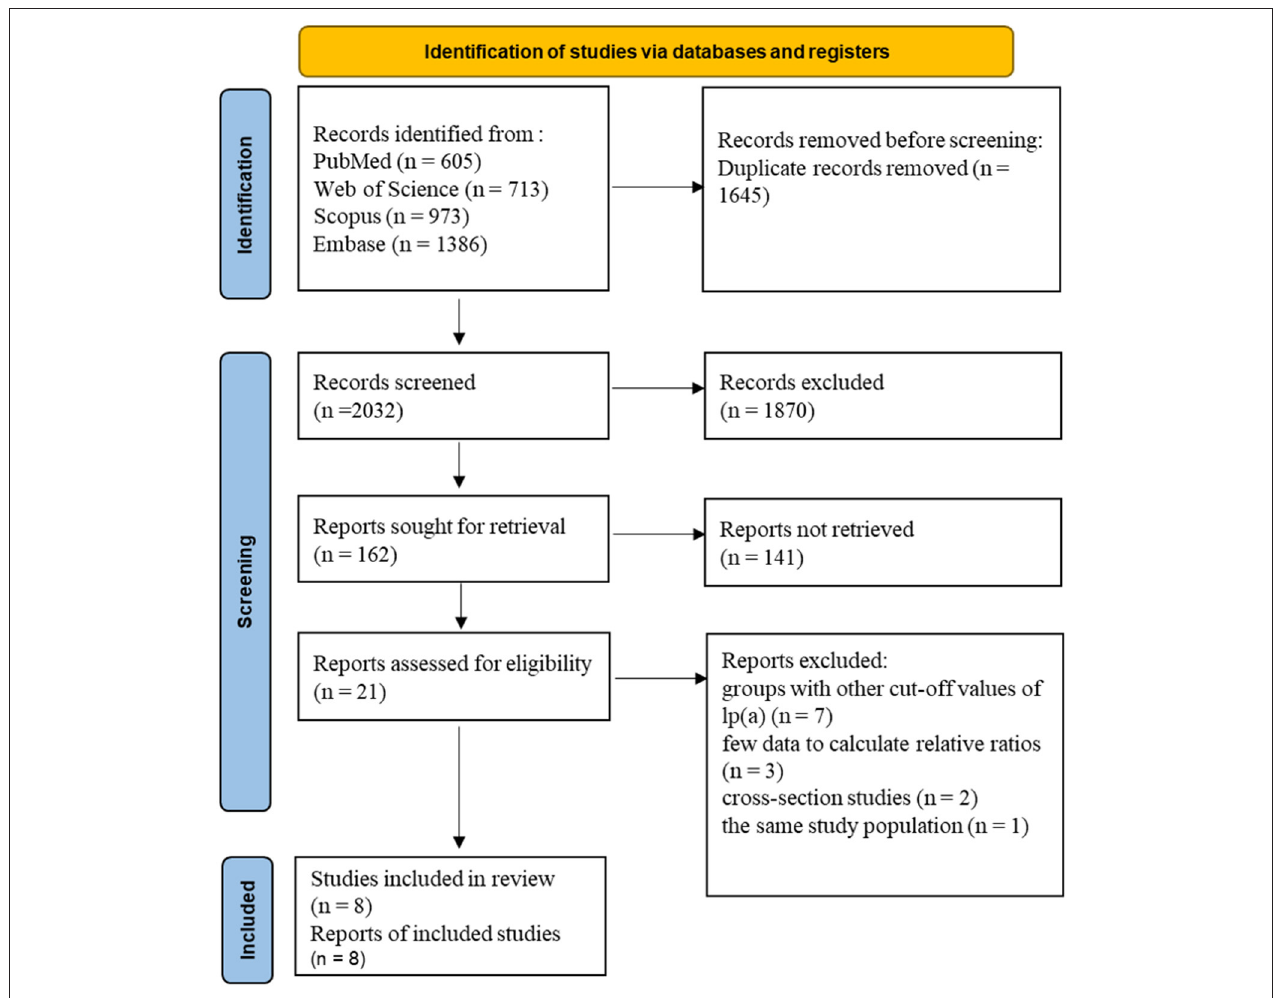
FIGURE 1 | Flow diagram of